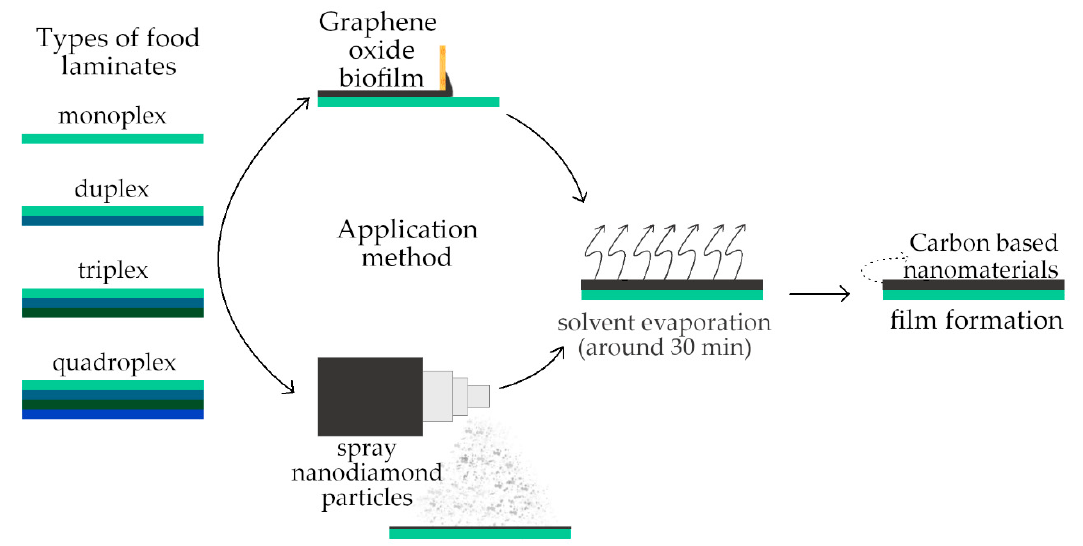
Figure 2. Schematic representation of the carbon based nanomaterials film